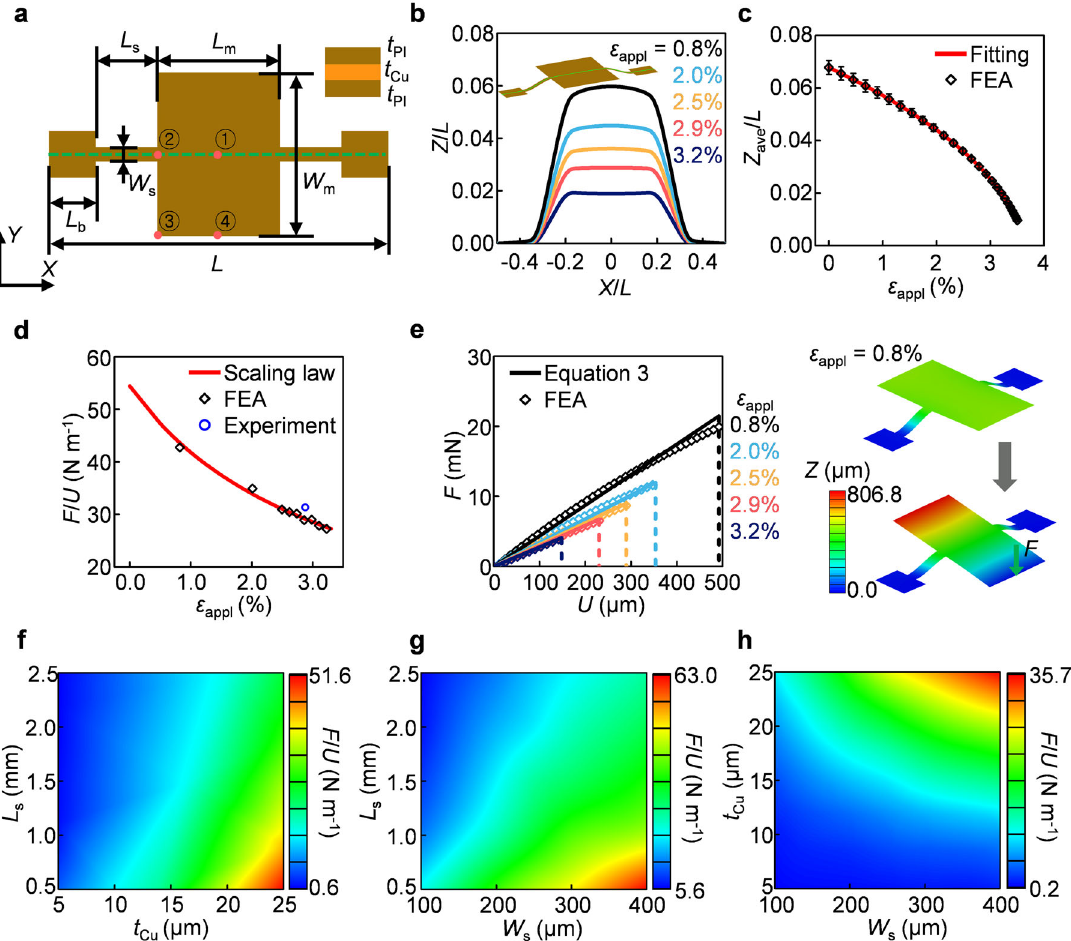
Fig. 2 Mechanical tunability of the 3D seesaw-like mesostructure. a Schematic illustration of geometric parameters of the precursor pattern used to assemble the 3D seesaw-like mesostructure, including thickness t ; supporting ribbon width W s , and length L s ; mover width W m and length L m ; and the length L b of bonding sites. b Pro fi le of the 3D seesaw-like mesostructure (along with the green line) under different applied strains ( ε appl = 0.8%, 2.0%, 2.5%, 2.9%, and 3.2%). The inset shows the pro fi le of the 3D mesostructure. c Normalized average height ( Z ave / L ) of four points (point 1~4, shown in ( a )) as a function of applied strains ( ε appl ). d Scaling laws, FEA results, and measurements for the equivalent stiffness ( F / U ) as a function of applied strain ( ε appl ). e Out-of-plane compressive force as a function of Z -direction displacement ( U ) under different applied strain ( ε appl = 0.8%, 2.0%, 2.5%, 2.9%, and 3.2%). The right panel shows the Z coordinate under the applied strain ( ε appl = 0.8%). f Contour plot of the equivalent stiffness ( F / U ) of the 3D seesaw-like mesostructure in terms of L s and t Cu for W s = 350 μ m and ε appl = 1.2%. g Contour plot of